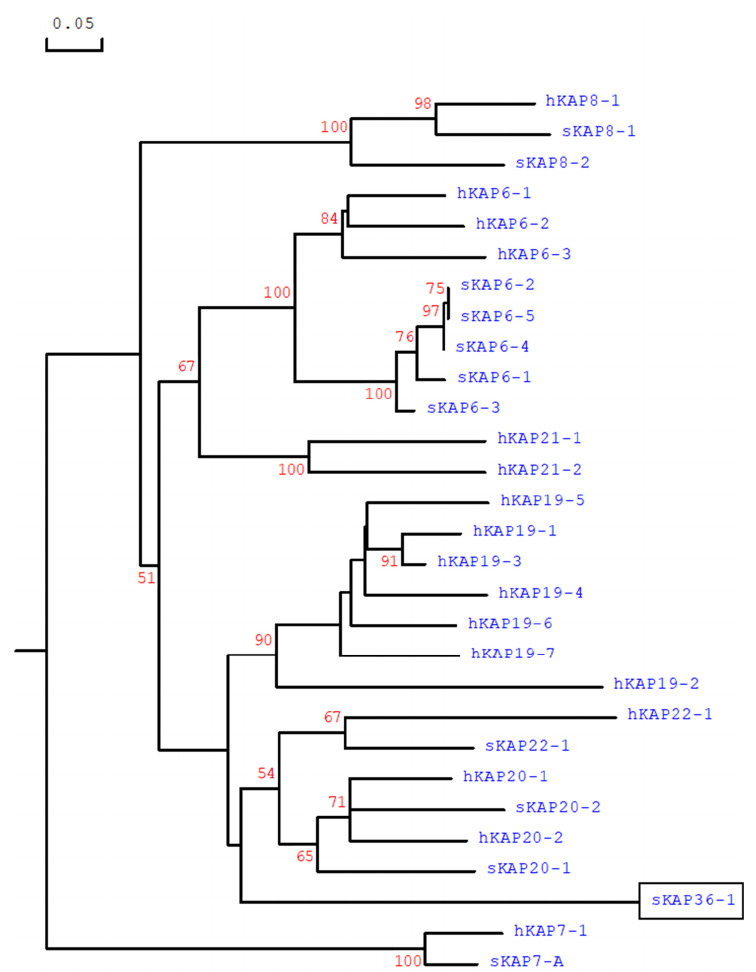
Figure 2. Phylogenetic tree of the HGT-KAPs identified in sheep and human. The tree was constructed using the predicted amino acid sequences. The numbers at the forks indicate the bootstrap confidence values and only those equal to or higher than 50% are shown. The sheep KAPs are indicated with a prefix “s”, whereas the human sequences are indicated with “h”. The newly identified ORF is designated as sheep KAP36-1 gene and is indicated in box. The GenBank accession numbers for other sheep HGT-KAPs are NM_001193399 (sKAP6-1), KT725832 (sKAP6-2), KT725837 (sKAP6-3), KT725840 (sKAP6-4), KT725845 (sKAP6-5), X05638 (sKAP7-1), X05639 (sKAP8-1), KF220646